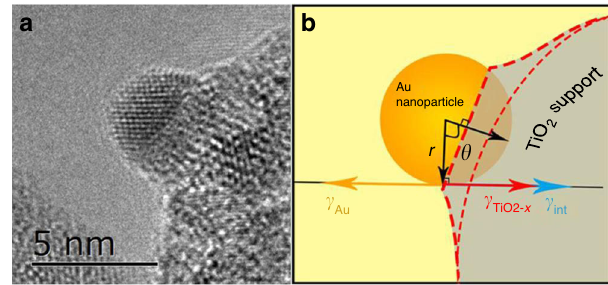
Fig. 4 Establishment of the thermodynamic equilibrium model. a Representative HRTEM image of Au-3nm-H400. b Schematic of encapsulation of Au particle (in a spherical segment) by TiO 2 support. r (black arrow) represents the radius of Au particle, and γ Au (orange arrow), γ (red arrow), and γ int (blue arrow) are the surface tensions of the Au TiO 2 (cid:1) x particle, TiO 2 support, and the interface between them. The thick and thin dashed red line in ( b ) indicate the outline of the encapsulation layer and the outline of the original TiO 2 support, respectively.